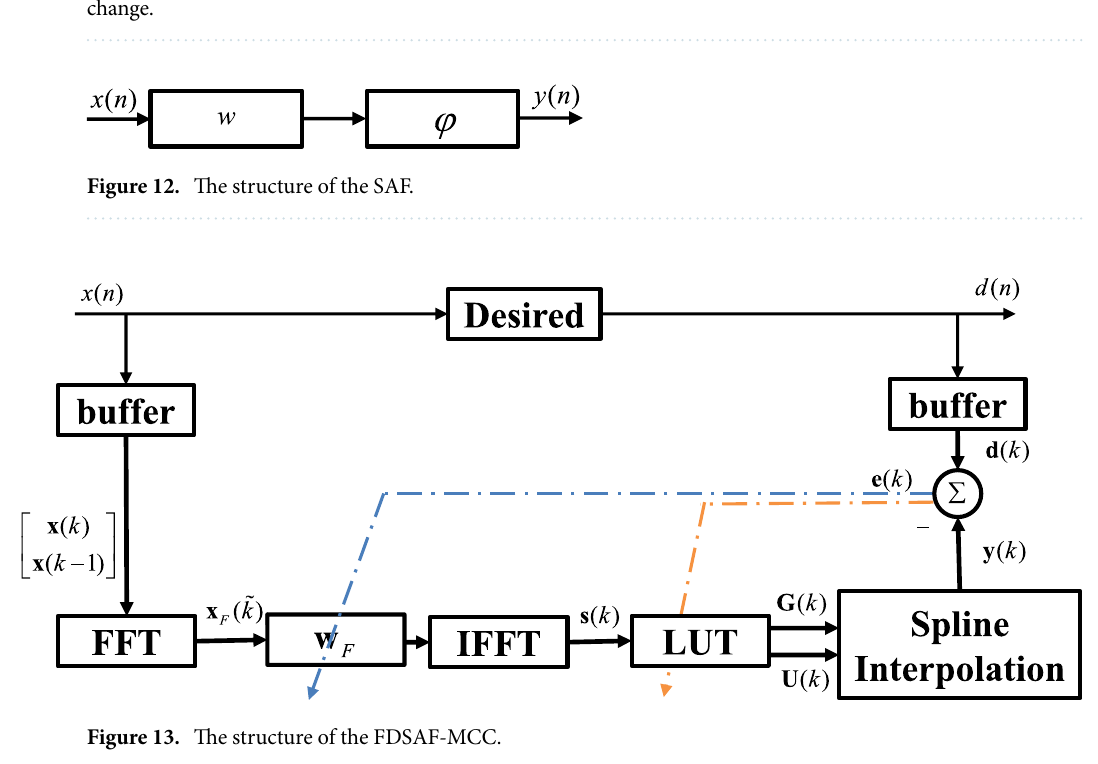
Figure 13. The structure of the